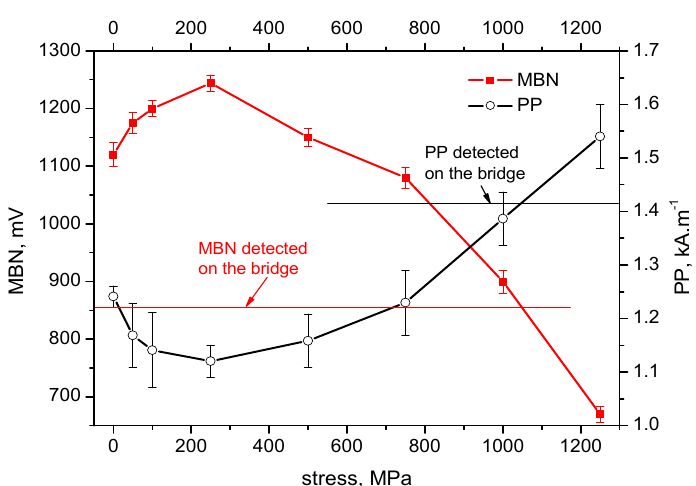
Figure 5. MBN and PP as a function of stress—wire n.2.